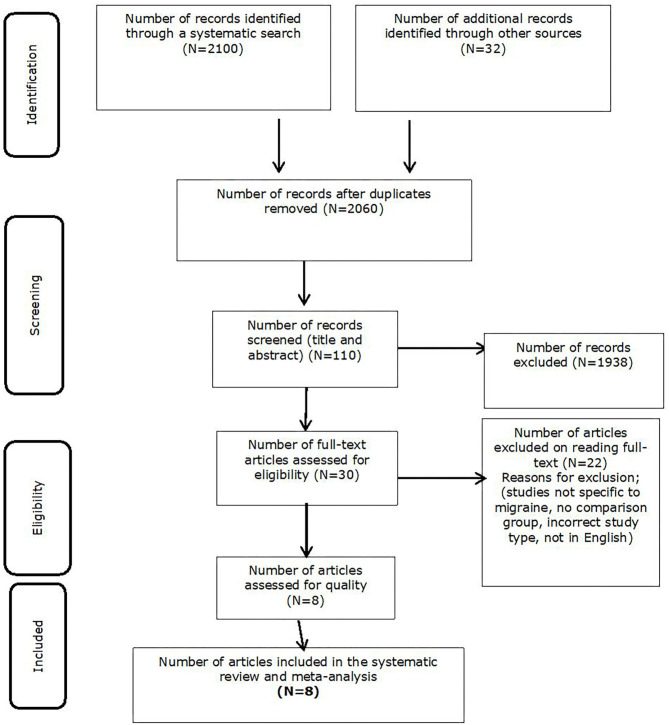
PRISMA of study selection.